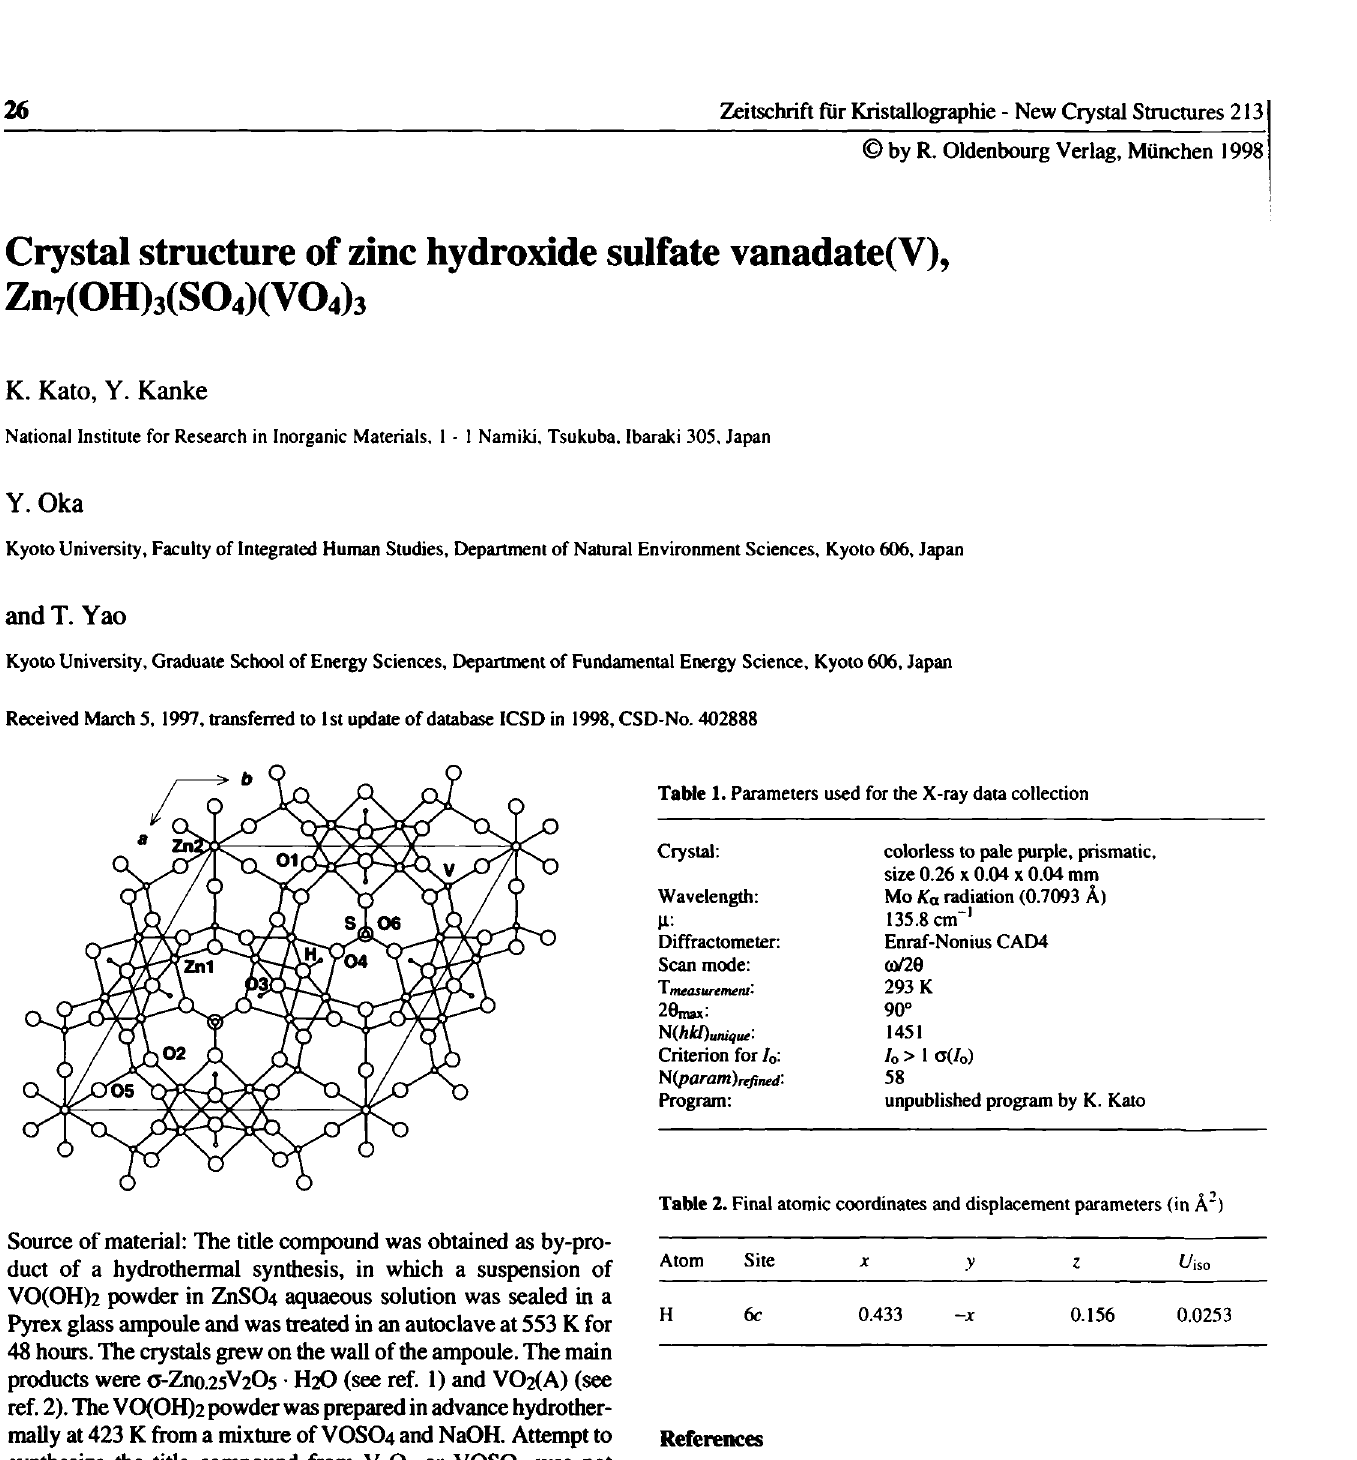
Table 2. Final atomic coordinates and displacement parameters (in